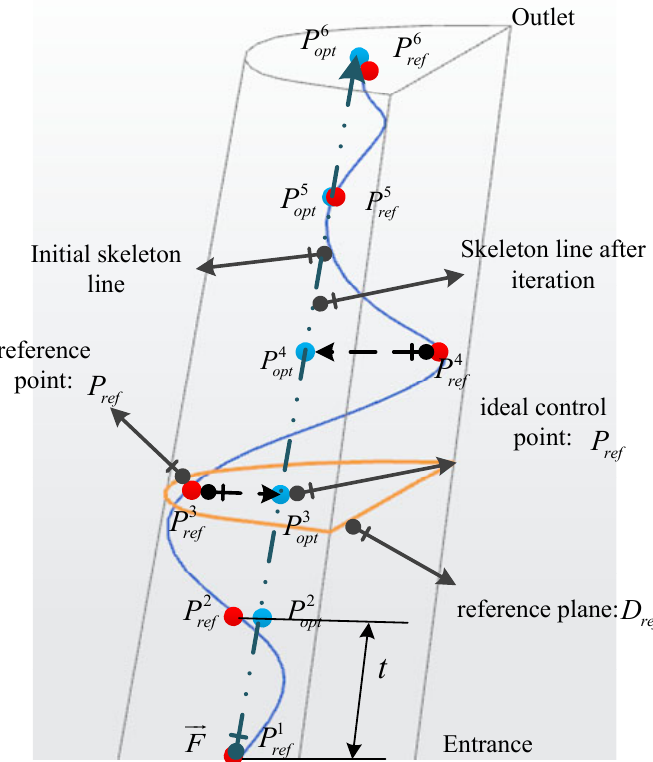
Figure 6. Basic idea of iterative optimization of the skeleton